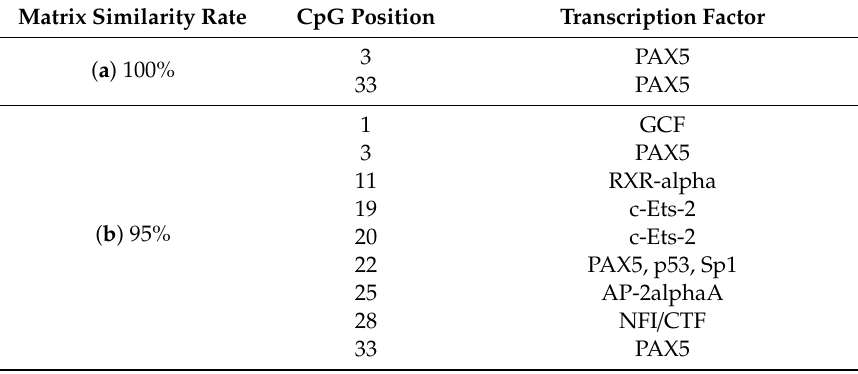
Table 2. Potential transcription factors capable of binding analyzed CpG sites. The ability of transcription factors to bind individual regions was assessed with di ff erent similarity rates, i.e., 100% ( a ), 95% ( b ), or 85% ( c